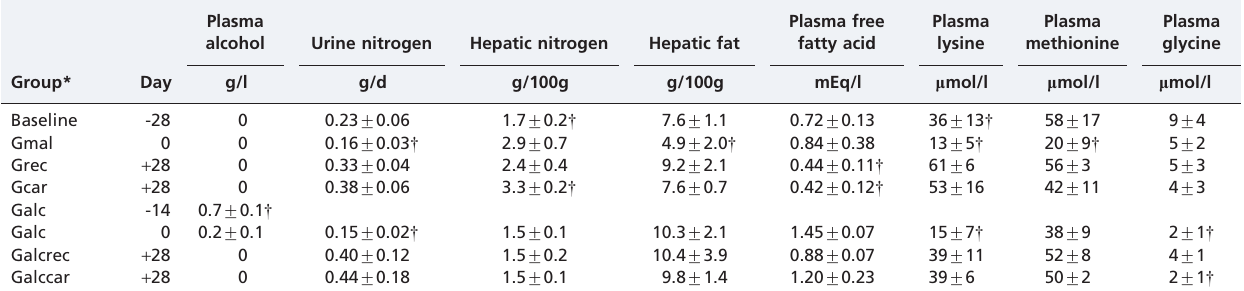
Table 2 - Data from different groups during the experimental protocol.